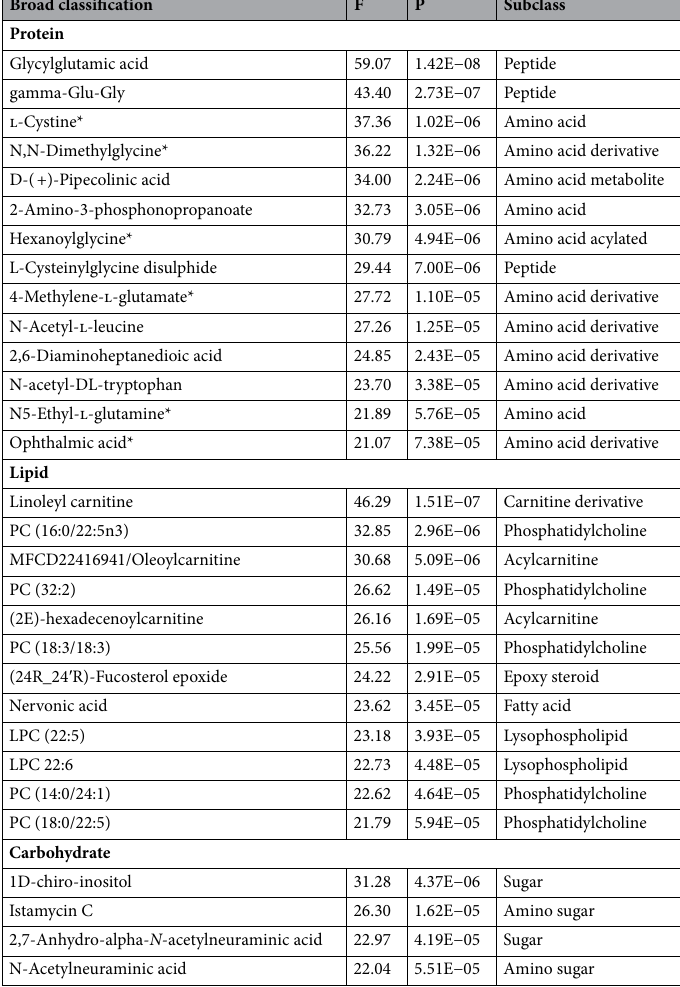
Table 1. Protein, lipid and carbohydrate differences observed between the dingo and domestic dog using type III ANOVA. *Non-essential amino acid derivatives and metabolites. DF =